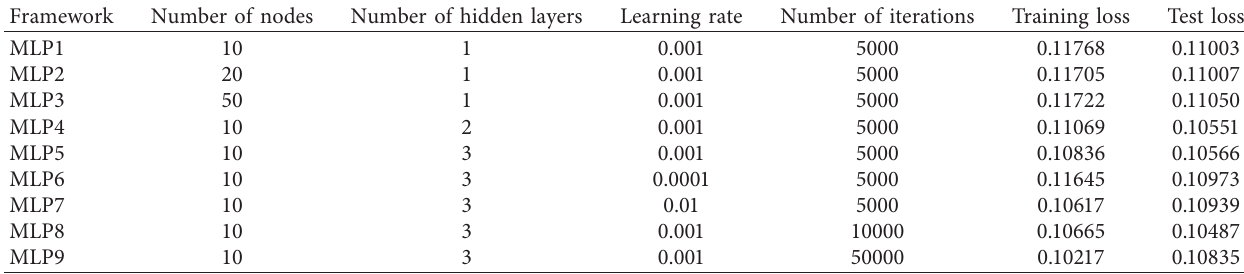
Table 2: Training loss and test loss of MLP frameworks with different parameters.